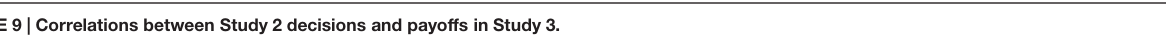
TABLE 9 | Correlations between Study 2 decisions and payoffs in Study 3. Scores Uncond. Cond.